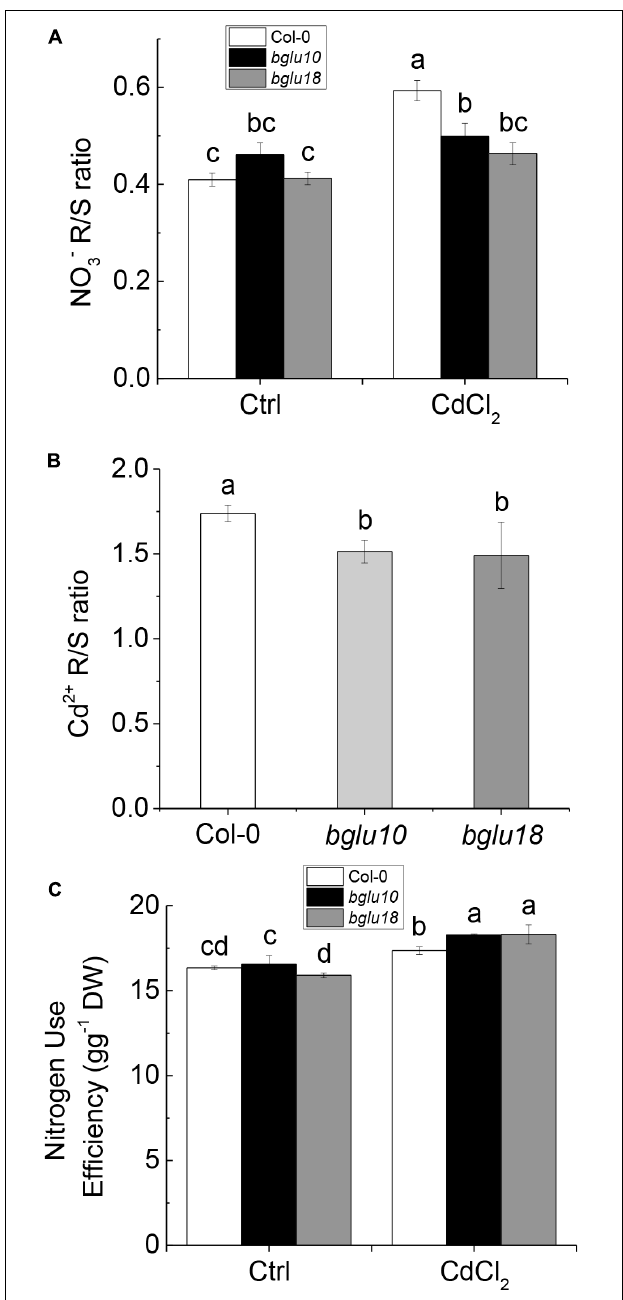
FIGURE 4 | Nitrate and cadmium distribution in Arabidopsis wild-type (Col-0) and ABA mutants ( bglu10 and bglu18 ) as well as NUE (nitrogen use efficiency). (A) [NO − 3 ] ration between root and shoot under control and Cd treatment. (B) [Cd 2 + ] ration between root and shoot. (C) NUE of wild-type and ABA mutants under normal treatment and Cd stress. Data represent means ± SE ( n = 4). Bars with the same letter indicate no significant difference at P < 0.05 level by the method of